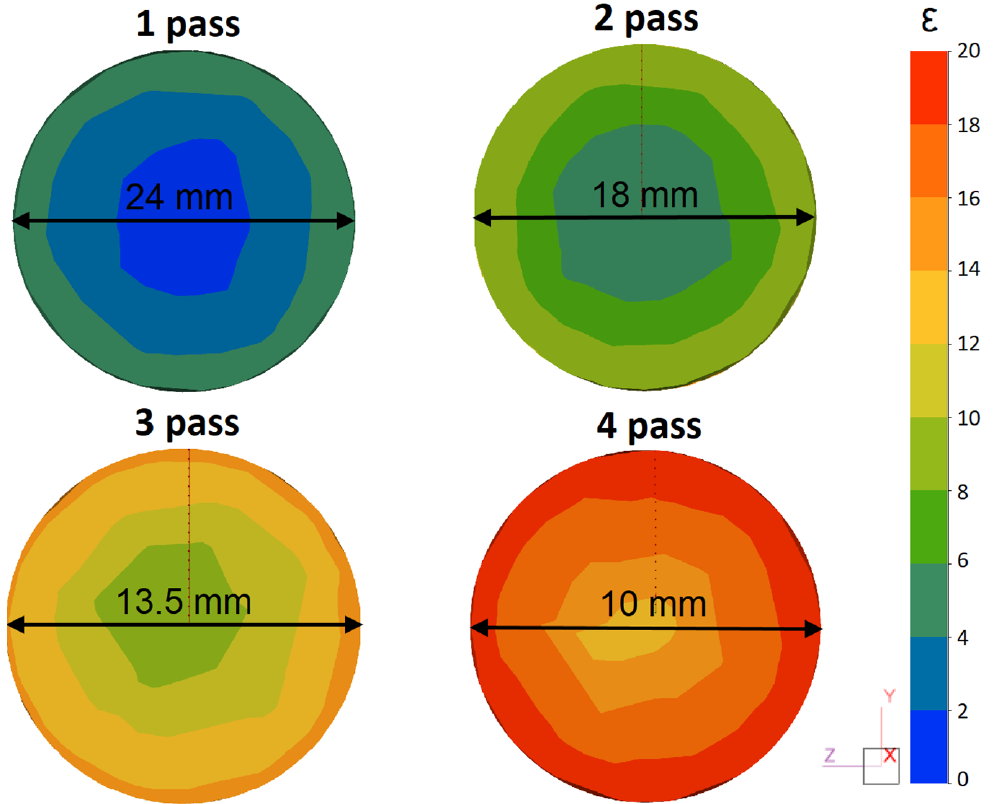
Figure 5. Distribution of effective strain over the cross ‐ section of the rod after each pass.